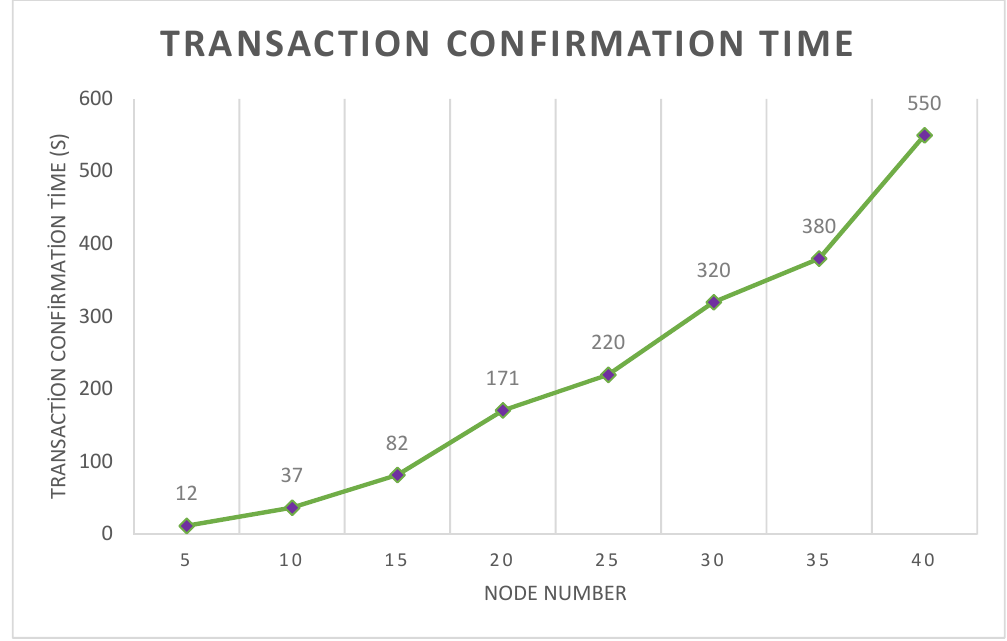
Figure 14. Transaction confirmation time of blockchain-based system.